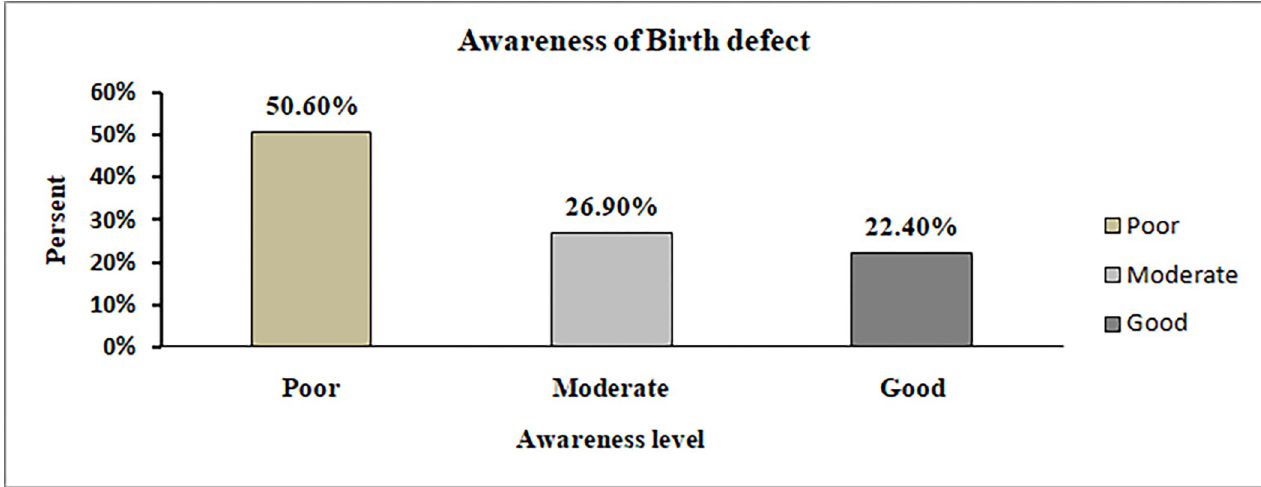
Fig 2. Awareness level of birth defect among pregnant women attending antenatal care in public health facilities at Dire Dawa, Eastern Ethiopia.